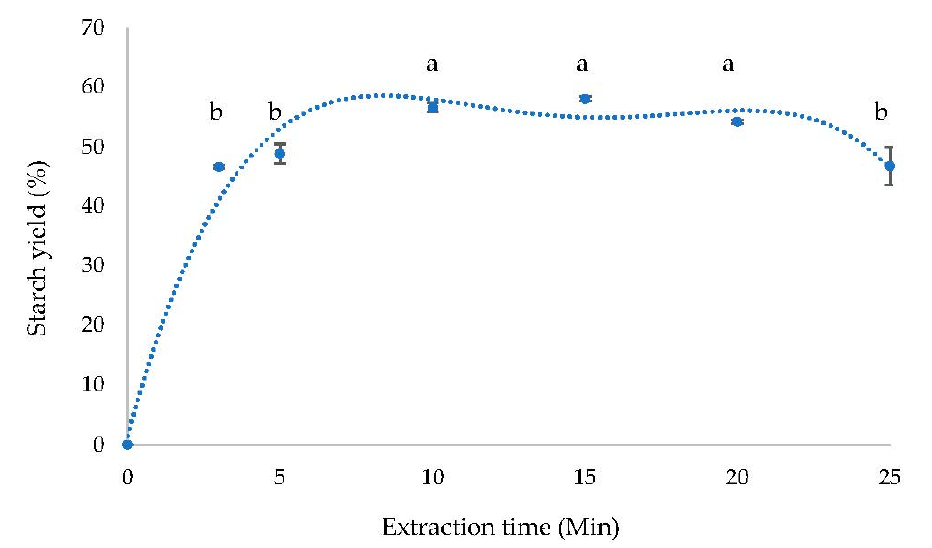
Figure 5. Extraction kinetics of cassava starch extraction using UAE. Different description letters indicate a significant difference ( p <